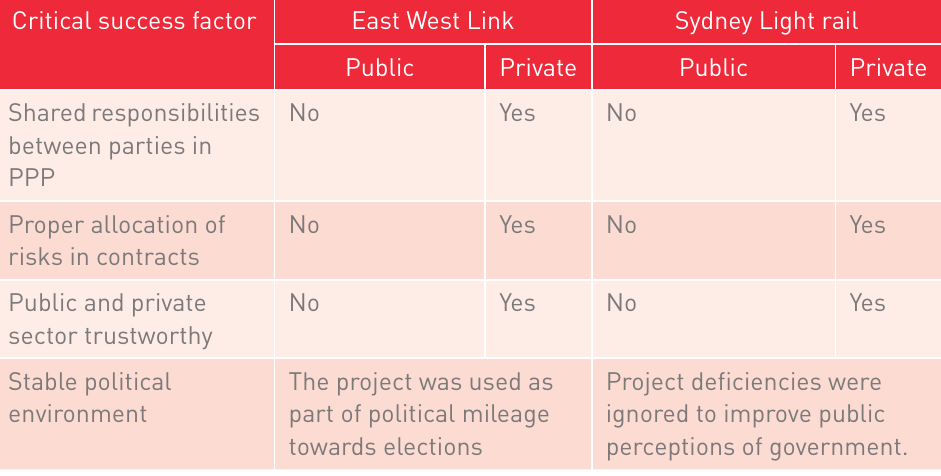
Critical success factor with their impact on projects